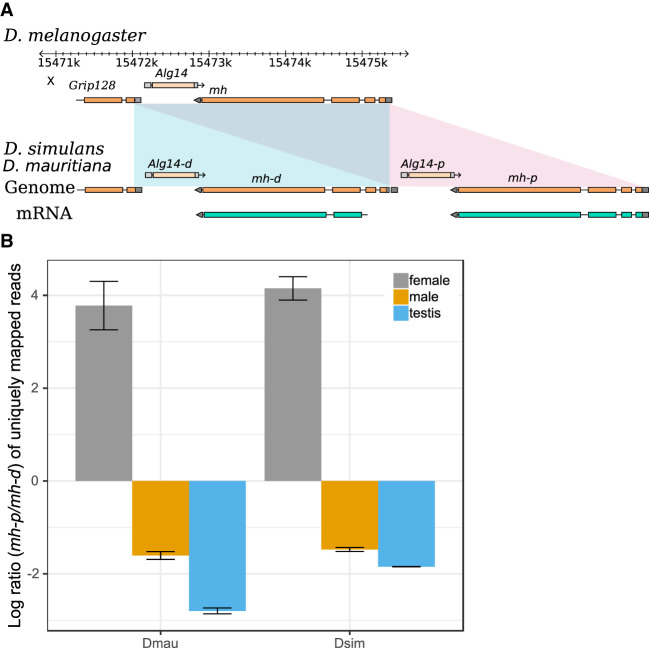
The expression divergence of maternal haploid (mh) duplicates in the sim-complex species. (A) The sim-complex shares a tandem duplication of mh and Alg14 genes. The expression of both mh copies is supported by Iso-Seq and Illumina transcriptome data. (B) The proximal copy of mh (mh-p) is primarily expressed in females, and the distal copy (mh-d) shows testis-biased expression in both D. mauritiana and D. simulans.